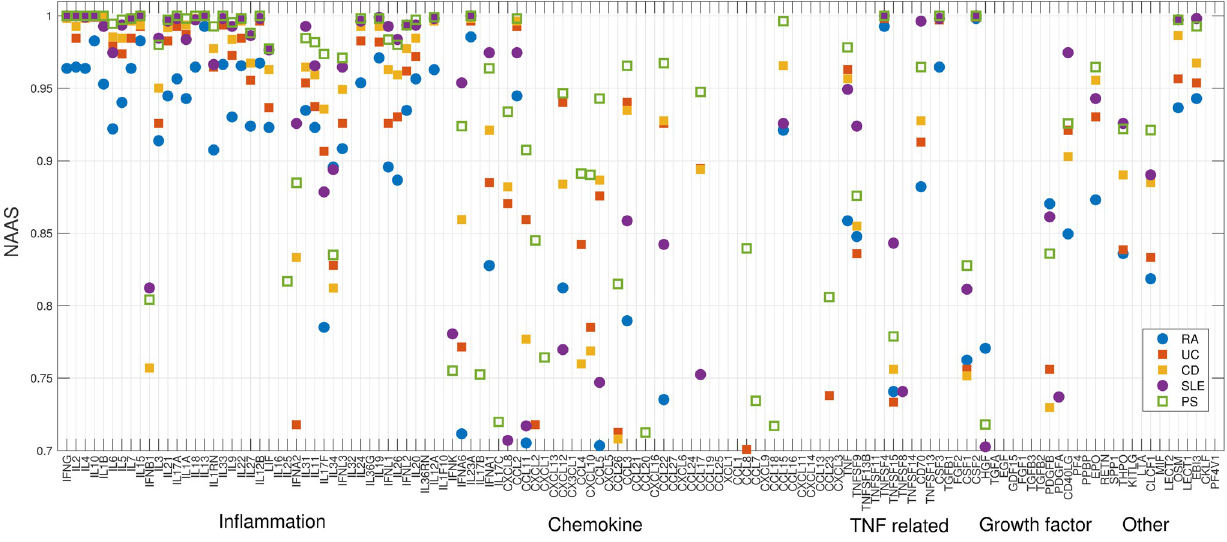
Fig 9. Disease-specific cytokine profiles of five immune disorders. The Y-axis shows the Probability of Association between each cytokine and the five immune disorders: rheumatoid arthritis (RA), psoriasis (PS), ulcerative colitis (UC), Crohn’s disease (CD) and systemic lupus erythematosus (SLE). A conserved association pattern is observed in inflammation-related cytokines, while differential patterns are observed in other types of cytokines.